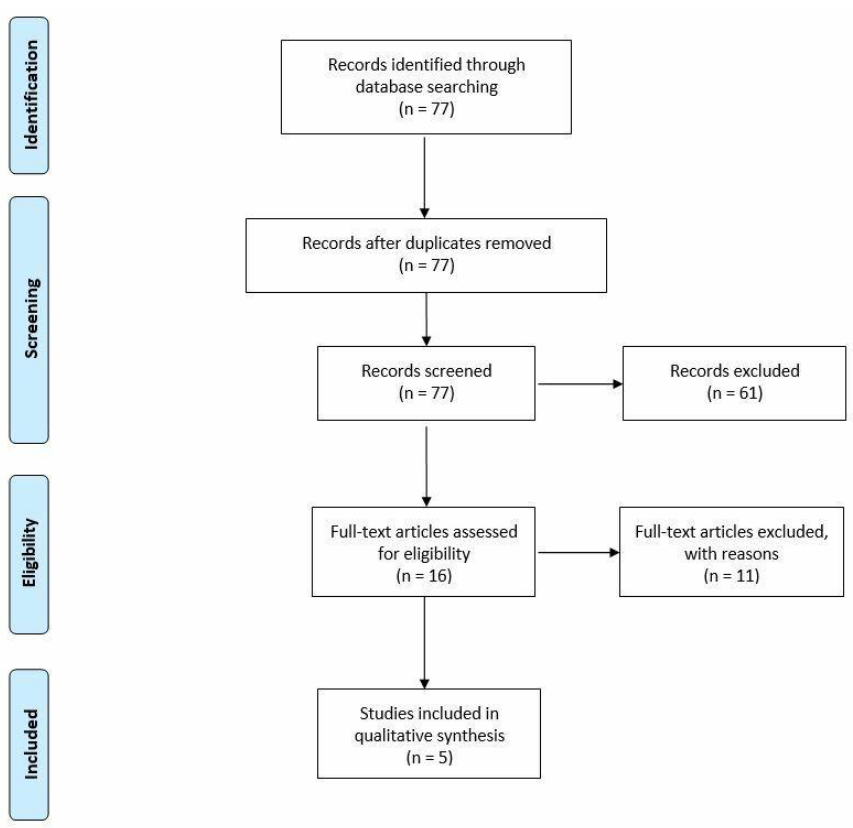
Figure 2. Prisma flowchart of the literature review conducted.